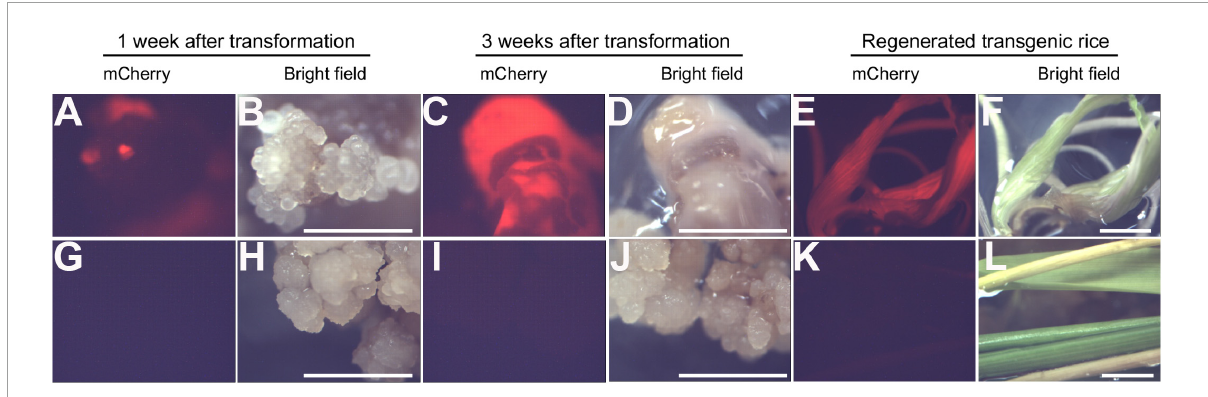
FIGURE3 Positive transgenic rice confirmed through epifluorescence microscopy. (A–F) Transgenic rice calli (A–D) and seedling (E,F) after 1 week of transformation (A,B) , 3 weeks of transformation (C,D) , and shoot regeneration (E,F) . (G–L) . Non-transformed control rice calli (G–J) and seedling (K,L) after 1 week of transformation (G,H) , 3 weeks of transformation (I,J) , and shoot regeneration (K,L) . Scale bar = 1